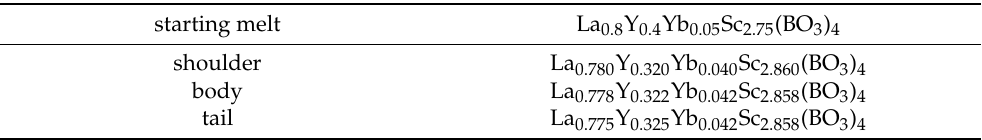
Table 7. Chemical compositions of samples cut from different regions of LYSB:Yb (4 at.%) crystal. Reprinted with permission from ref. [44], copyright 2020,